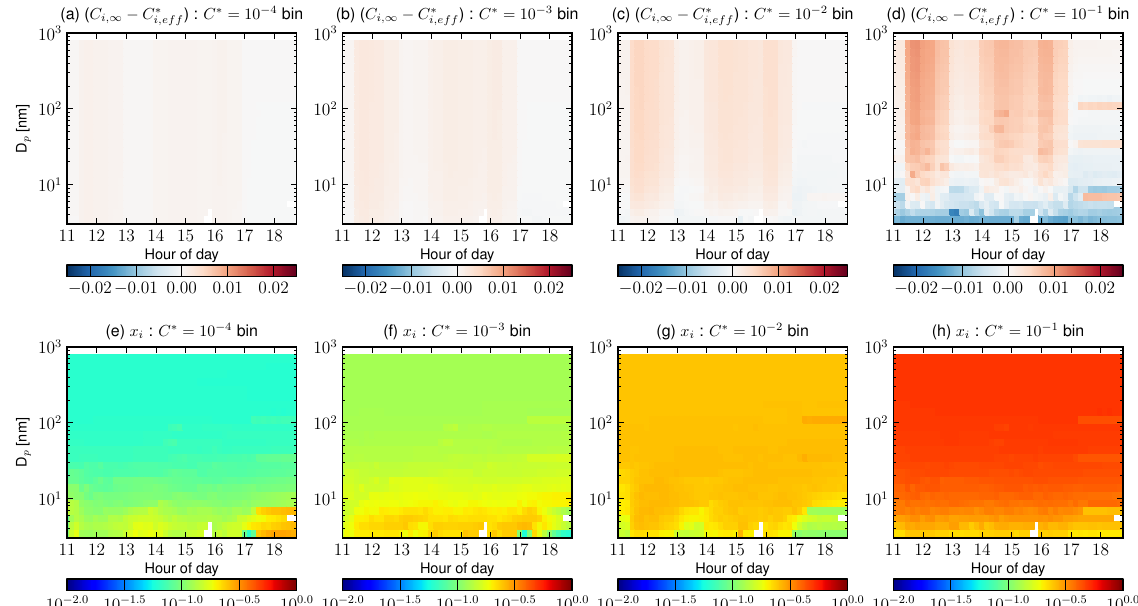
Fig. 6. Demonstration of how the surface tension effect can inhibit ultrafine particle growth for Hyyti¨al¨a on 10 April 2007. Panels (a–d) ) [µgm − 3 ] as a function of aerosol size and time for the C ∗ = 10 − 4 , 10 − 3 , 10 − 2 and show the condensational driving force ( C i, ∞ − C ∗ i, eff 10 − 1 [µgm − 3 ] volatility bins for the simulation where both pre-existing and freshly formed SOA has a LOGTRI volatility distribution, SOA does not partition into sulfate and water, the surface tension is 0.05Nm − 1 , and the accommodation coefficient is 1. Panels (e–h) show the mass mixing ratio ( x i , note that the volatility basis set uses mass mixing ratios rather than molar mixing ratios) as a function of aerosol size and time for the same